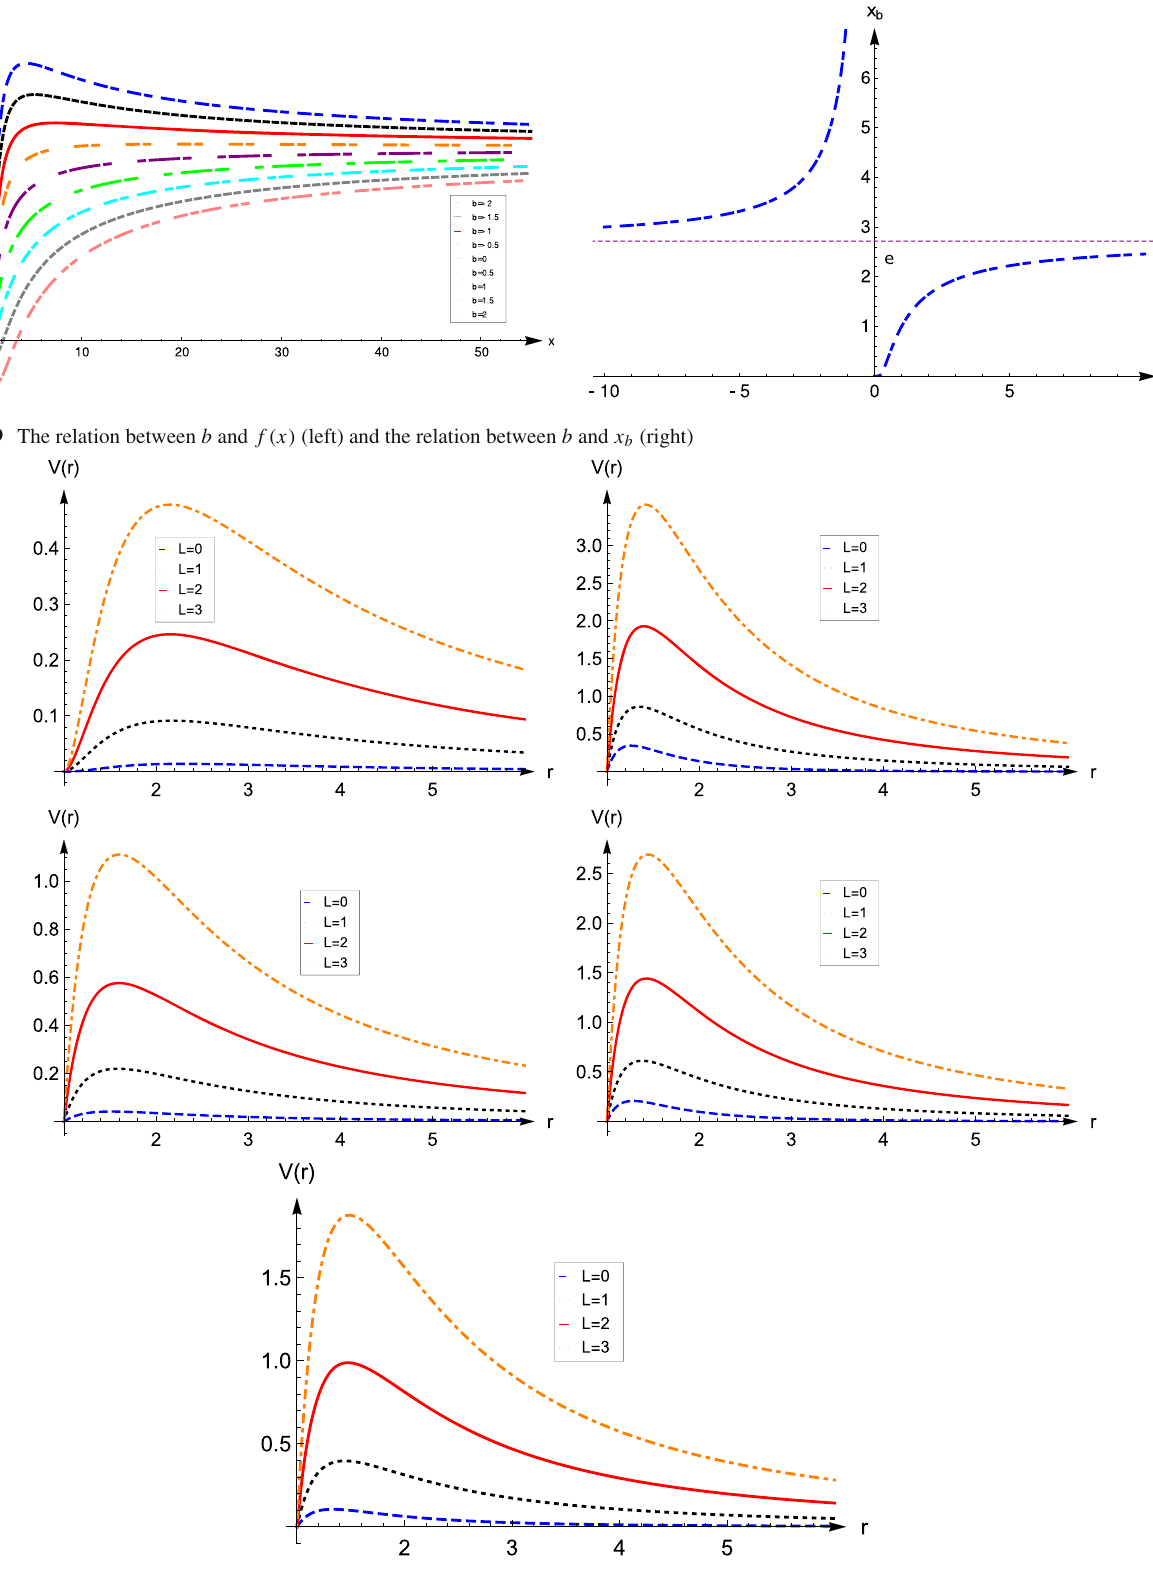
Fig. 10 V ( r ) versus r for b = 1 (up-left panel), b = − 1 (up-right panel), b = 0 . 5 (middle-left panel), b = − 0 . 5 (middle-right panel) and b = 0 (down